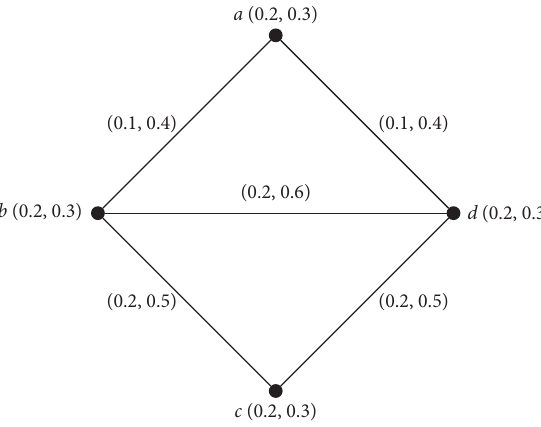
Figure 4: A connected VG G